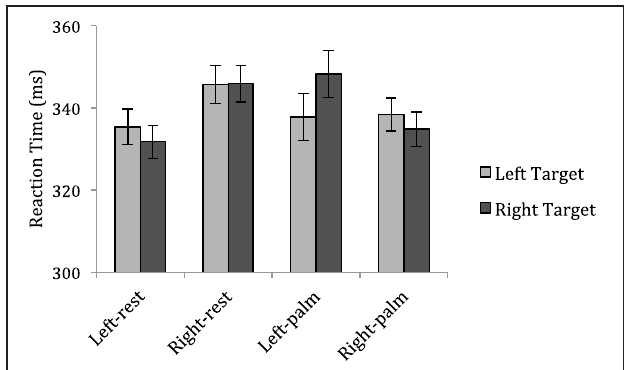
FIGURE 2 | Mean reaction times to detect targets in Experiment